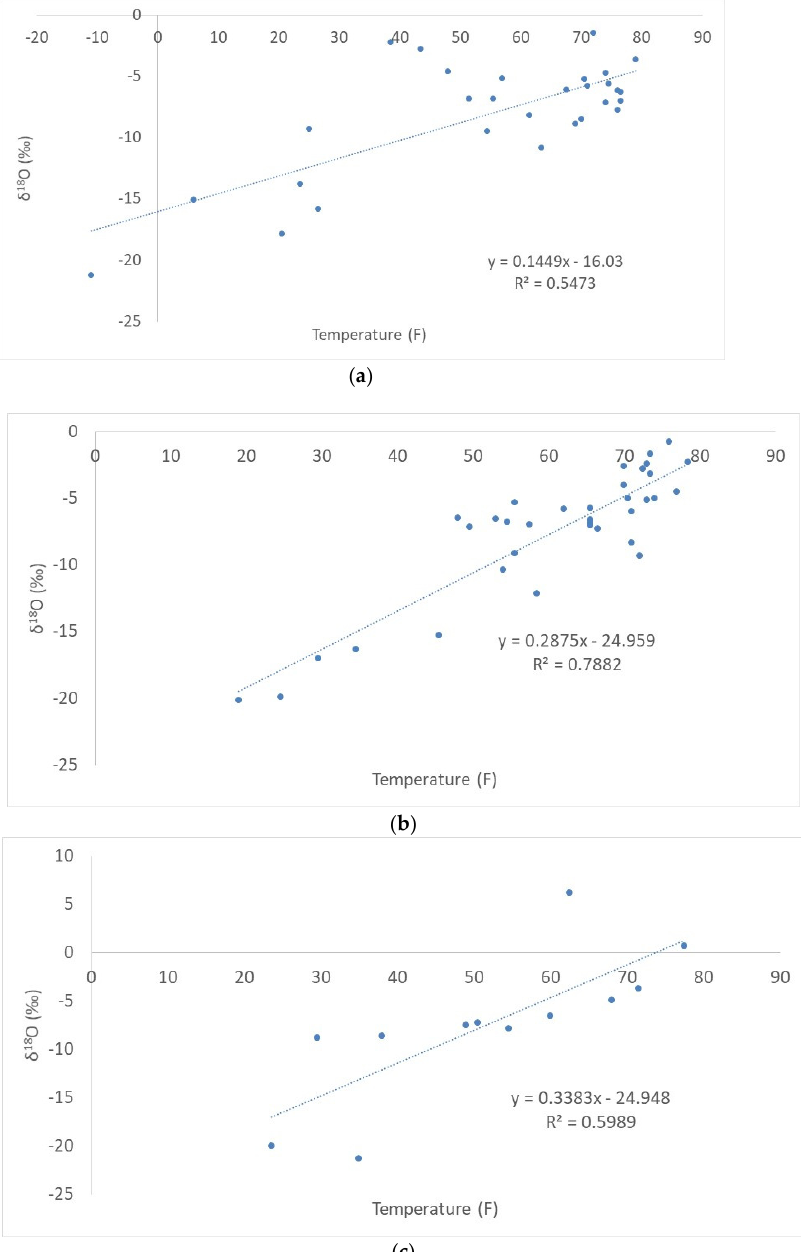
Figure 6. Linear relationship between temperature and δ 18 O at all three sites. ( a ) Waseca; ( b ) Tracy; ( c ) Beresford .